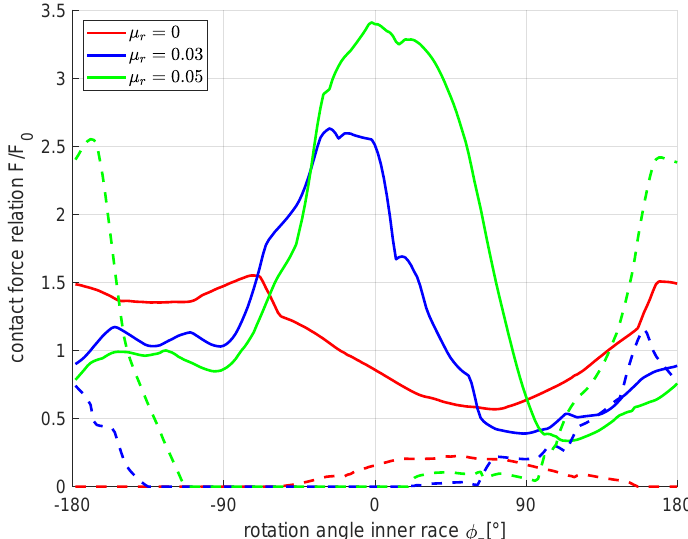
Figure 12. Track contact forces using different friction coefficients: solid line, track flank in load direction; dashed line, counter track flank (opposite load direction); and contact force relation F / F 0 , track force F related to F 0 for undeflected joint